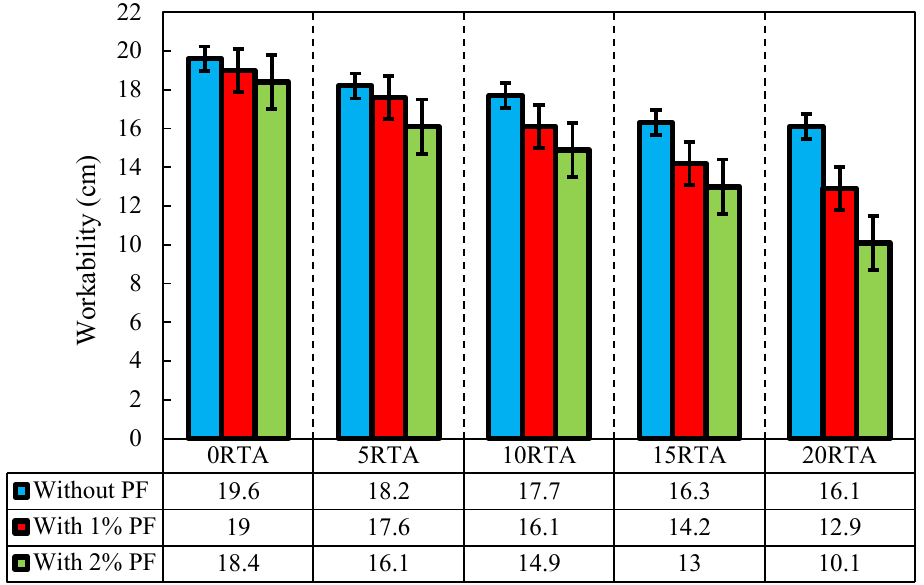
Figure 3. Effect of PF and RTA on the workability of samples.